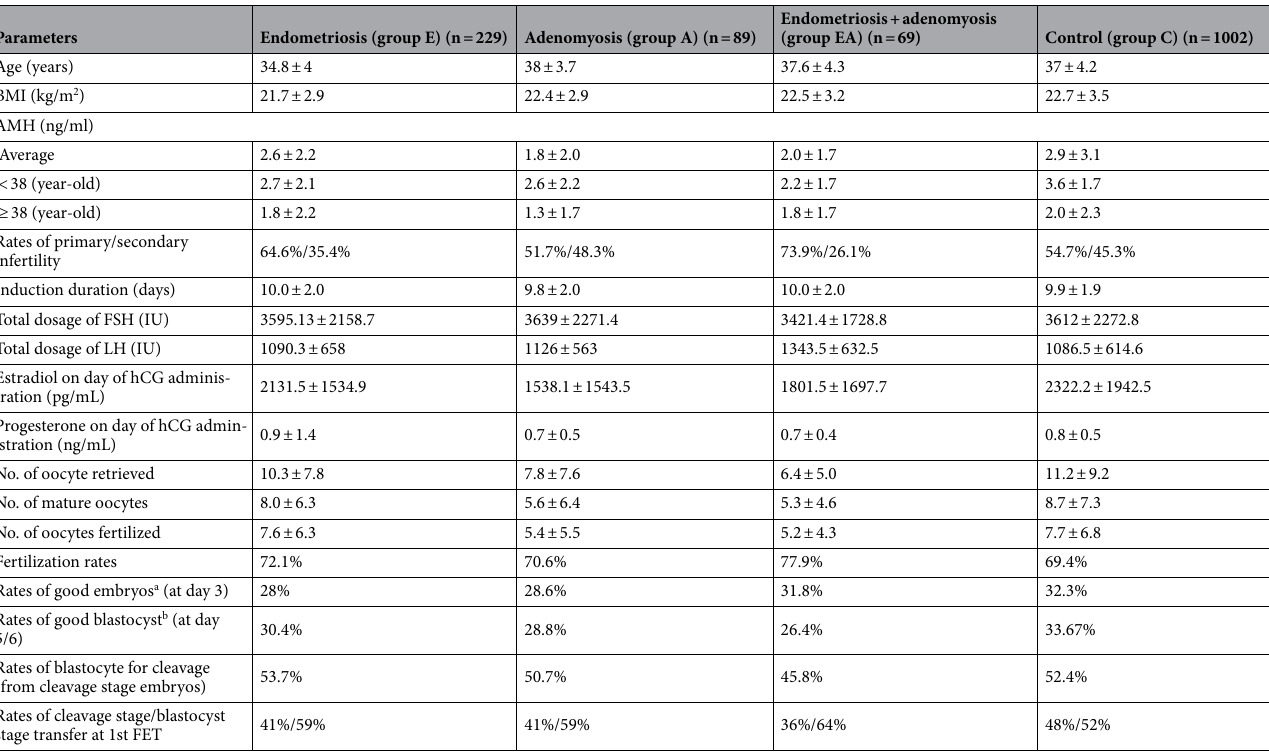
Table 1. Baseline demographics, cycle characteristics and culture results of the four groups. a Cleavage embryos were defined as good quality embryo if they were composed of at least seven-to-eight cell grade 1 or 2 on day 3, according to the Veeck classification system. b Grade according to Gardner classification system